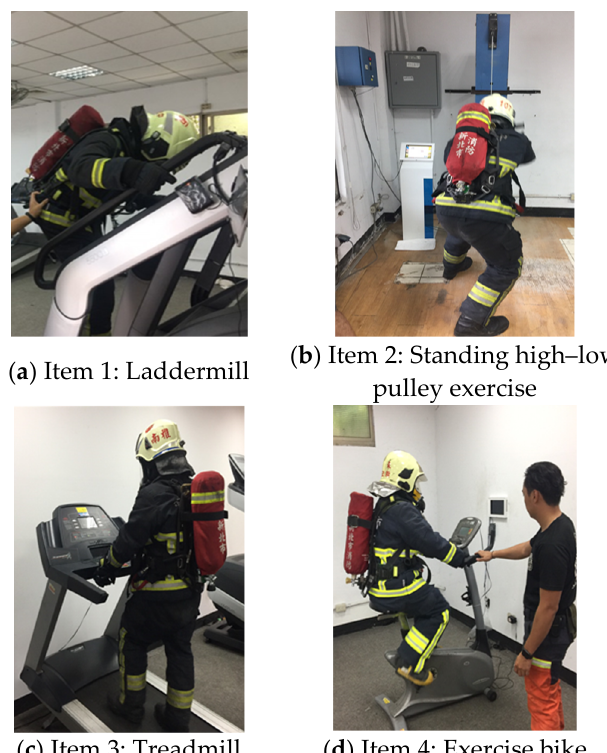
Figure 7. The four exercises for Part 2. ( a ) Laddermill ( b ) Standing high–low pulley exercise ( c ) Treadmill ( d ) Exercise bike.